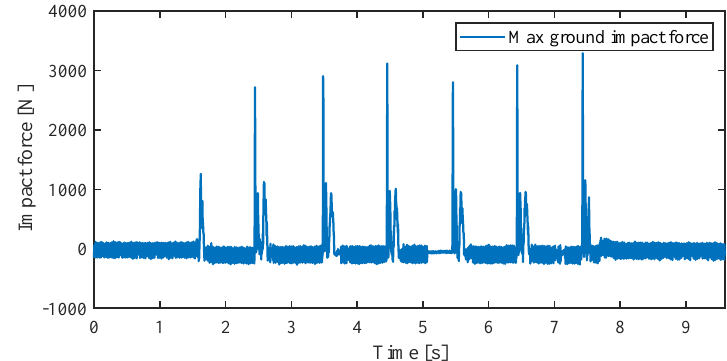
Figure 16. The experiment vertical jumping impact